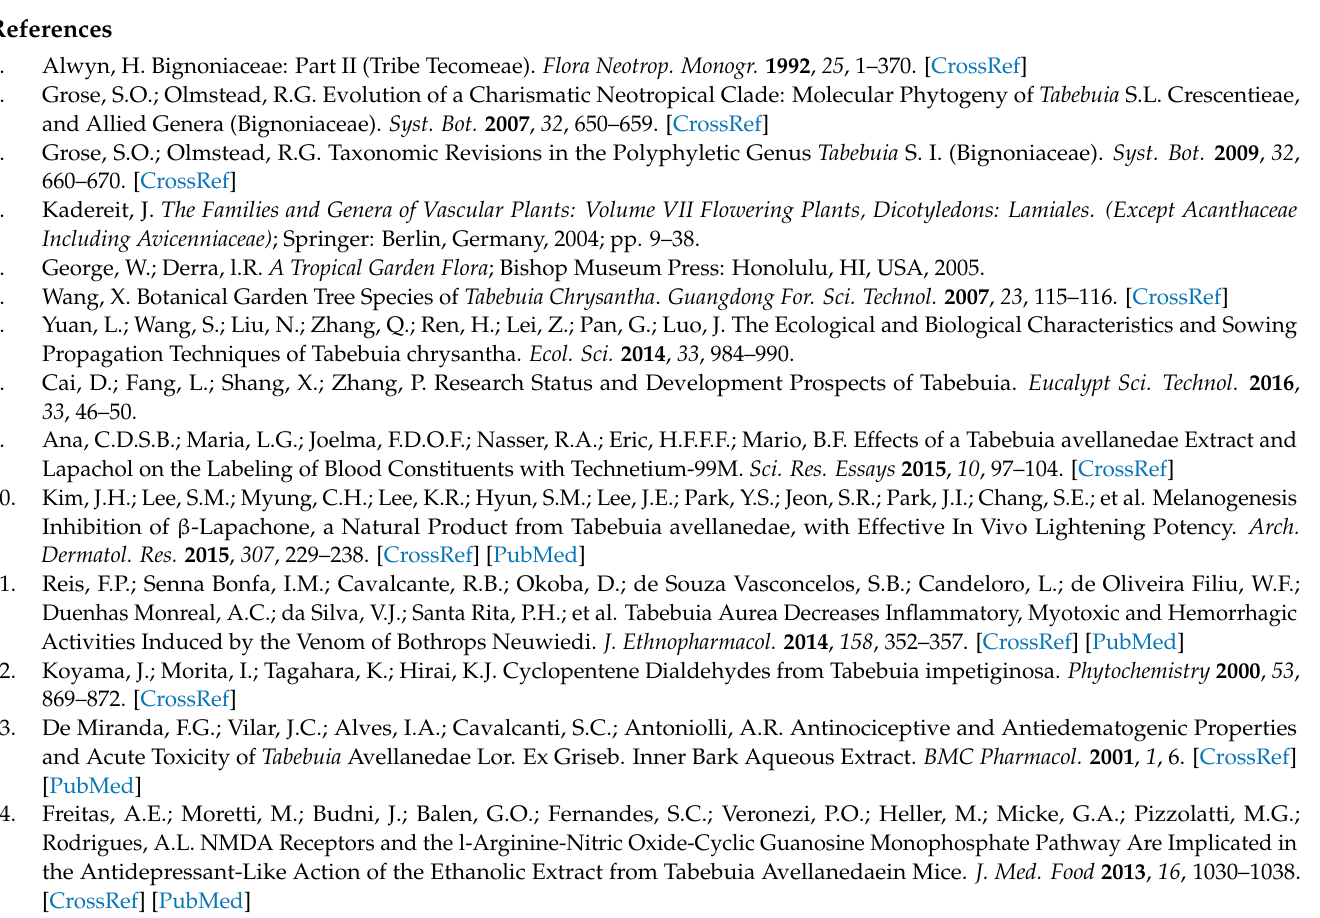
Table S1: Details of the primers of 8 genes involved in flavonoid synthesis; Table S2: KEGG pathway enrichment of metabolites in the bark and leaves of H. chrysantha ; Table S3: Flavonoid biosynthesis-related metabolites in the bark and leaves of H. chrysantha ; Table S4: Differentially accumulated metabolites involved in flavonoid biosynthesis in the bark and leaves of H. chrysantha ; Table S5: Transcription factors expressed in the bark and leaves of H. chrysantha ; Table S6: Differ- entially expressed transcription factors in bark and leaves of H. chrysantha ; Table S7: Flavonoid biosynthesis-related genes in the bark and leaves of H. chrysantha ; Table S8: Correlation analysis of flavonoid